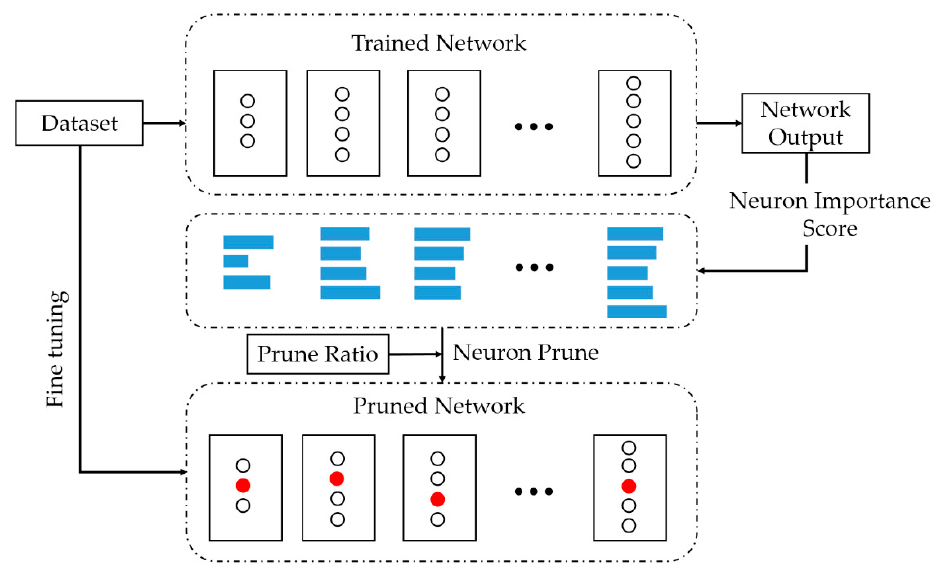
Figure 11. The neuron pruning process. The white ‘ ’ denotes the neuron in the network, the length of the blue rectangle represents the importance score of the corresponding neuron, and the red ‘ ’ represents the neurons that are pruned in the network.